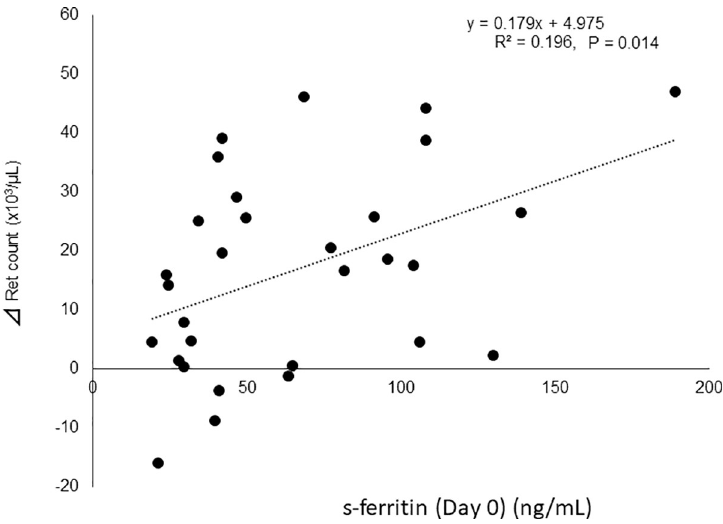
Fig 5. Correlation between change in Ret count from Day 0 to Day 28 and s-ft on Day 0. Change in Ret count showed a strong positive correlation with s-ft on Day 0 (p = 0.014).